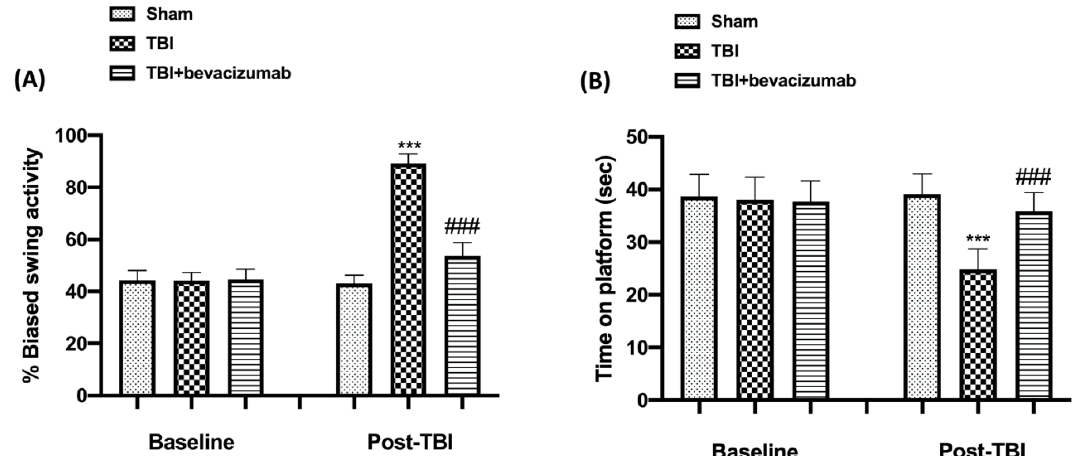
Figure 1. Bevacizumab helps recovery and improves behavioral function. At 24 h after TBI, mice showed significant impairments in motor deficits as revealed by appreciably biased swing activity ( A ) and reduced time to stay on rotarod ( B ). On the contrary, treatment with bevacizumab 1 h post-TBI significantly improved motor function evaluated by EBST ( A ) and Rotarod test ( B ). All data are expressed as mean ± SD from n = 5 mice for each group. *** p < 0.001 vs. Sham; ### p < 0.001 vs. TBI.